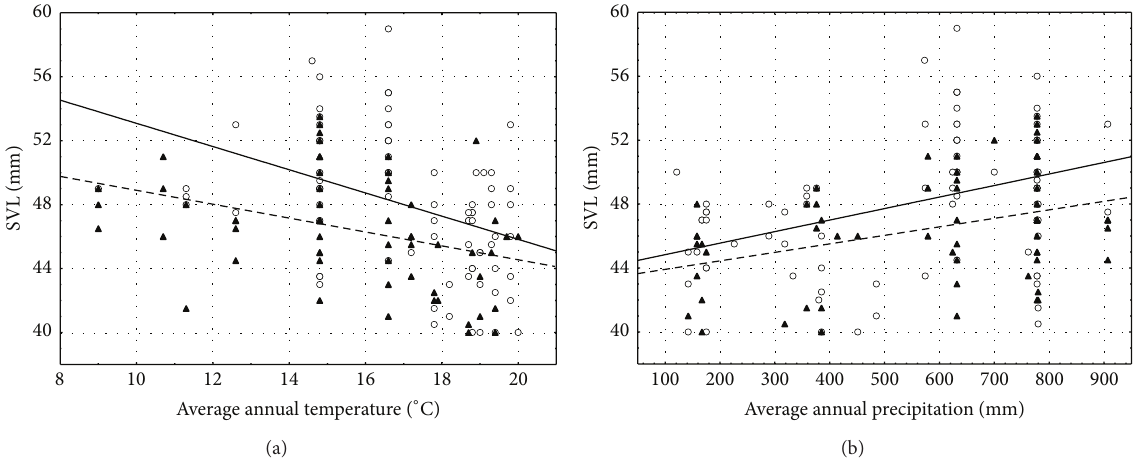
Figure 3: The relationship between SVL and (a) average annual temperature and (b) average annual precipitation in Ophisops elegans : solid line with circles: males; dashed line with triangles: